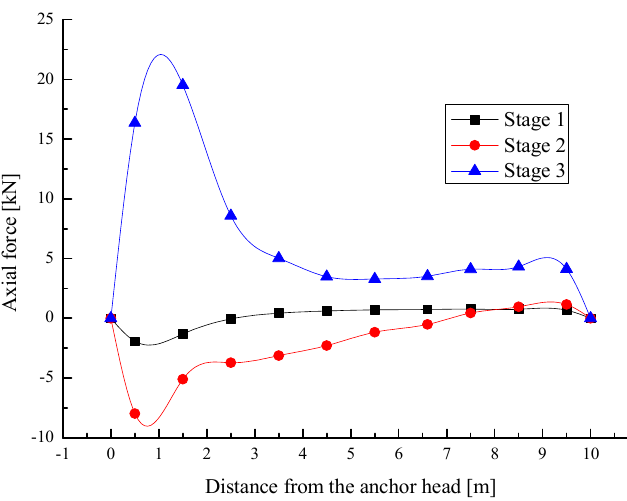
Figure 13. Axial forces of anchor #2 at different stages.